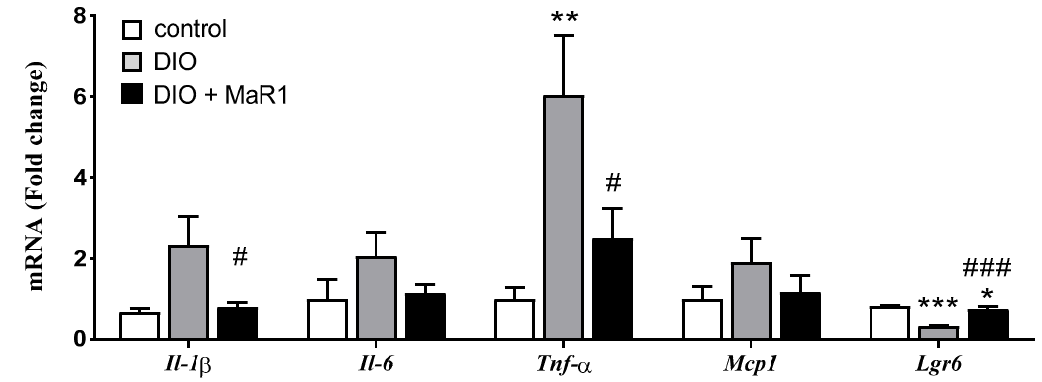
Figure 1. Effects of Maresin 1 (MaR1) on gene expression levels of Il-1 β , Il-6 , Tnf- α , Mcp-1, and Lgr6 in colon . Diet-induced obese (DIO) mice were treated by oral gavage with MaR1 (50 μ g/kg/day) for 10 days. Data are expressed as mean ± SE ( n = 7–8). * p < 0.05, ** p < 0.01, *** p < 0.001 vs. control and # p < 0.05, ### p < 0.001 vs. DIO mice.